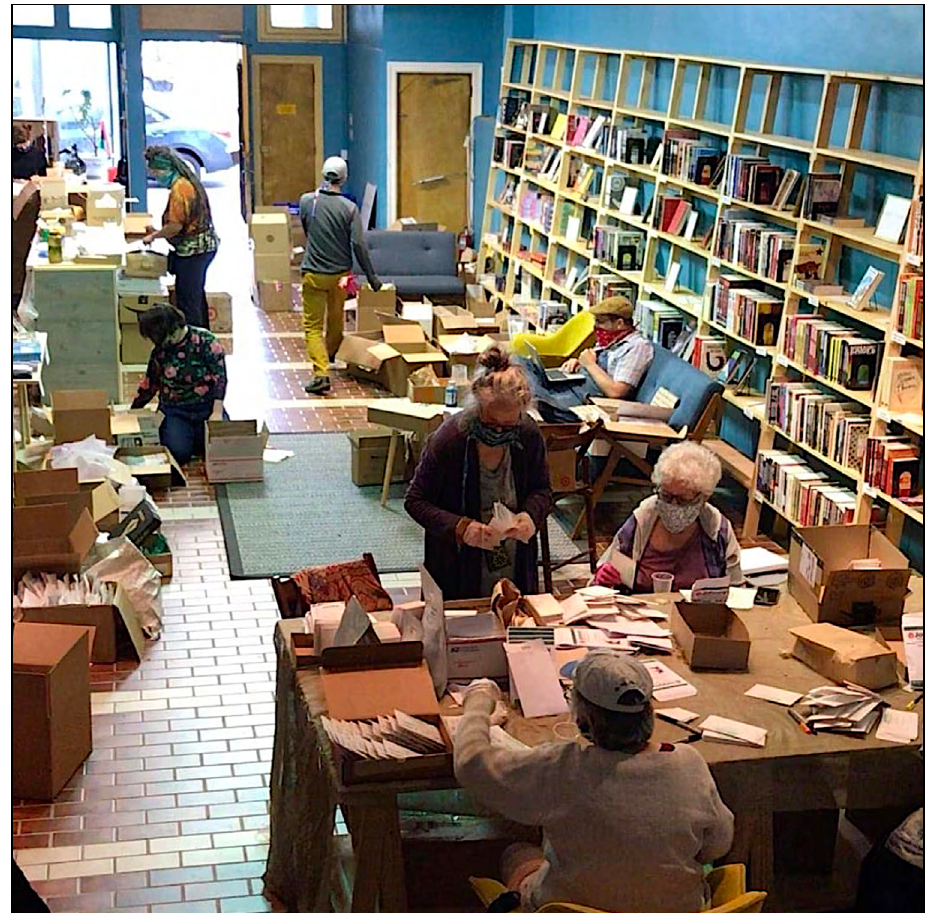
Figure 3 Cooperative Gardens Commission seed packaging, spring 2020. CGC